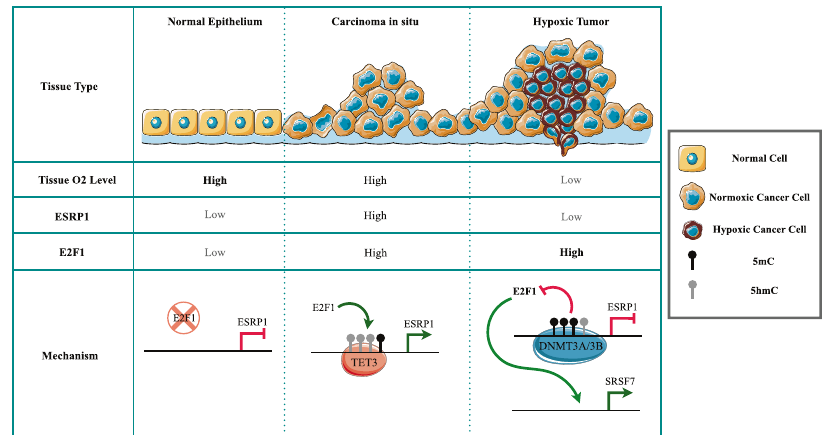
Supplementary Table S3. To generate promoter constructs, human ESRP1 (Gene ID: 54845) promoter sequence was retrieved from the Eukaryotic Promoter Database (EPD) (https://epd.vital-it.ch/). Different lengths of ESRP1 promoter constructs were PCR ampli fi ed from genomic DNA derived from MCF7 cells and inserted/ligated into pGL3 basic vector (Promega) between